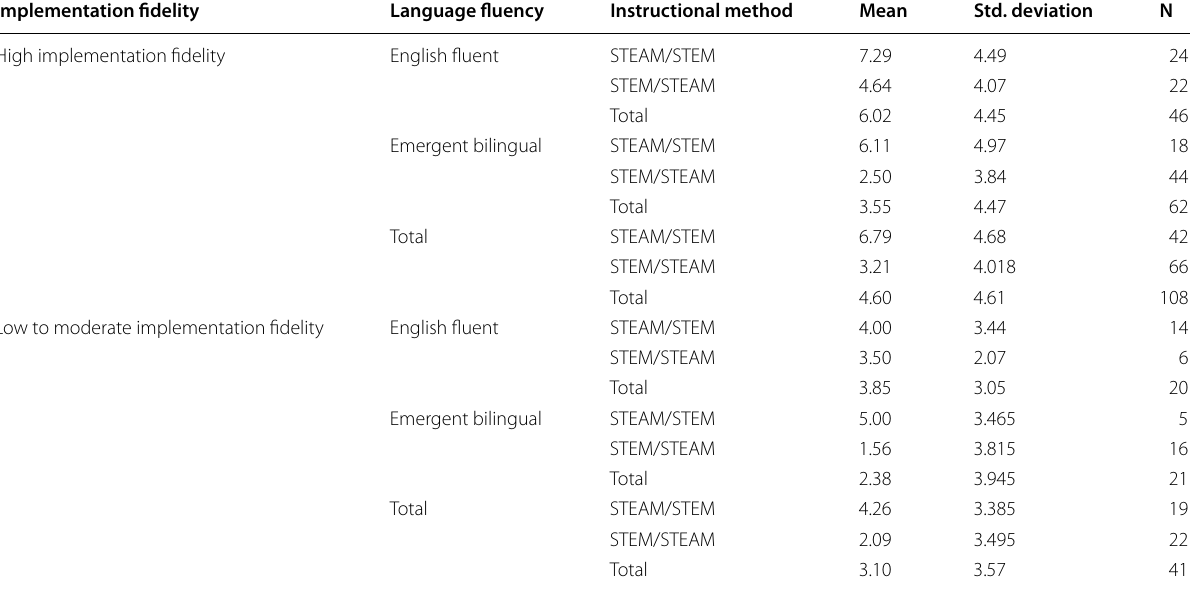
Table 1 Descriptive statistics via ANCOVA analysis of implementation levels, English fluency and instructional method related to total change scores for life science knowledge gained Implementation